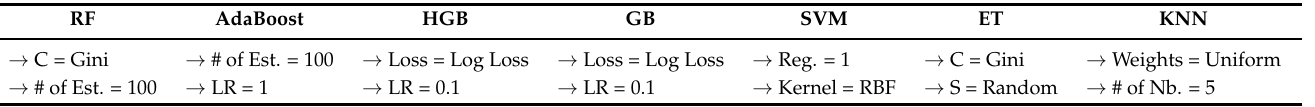
Table 3. The selected hyperparameters of the used machine learning